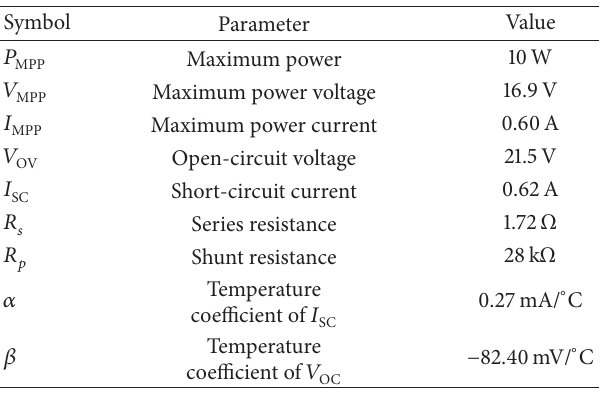
Table 1: KS-10 specifications.